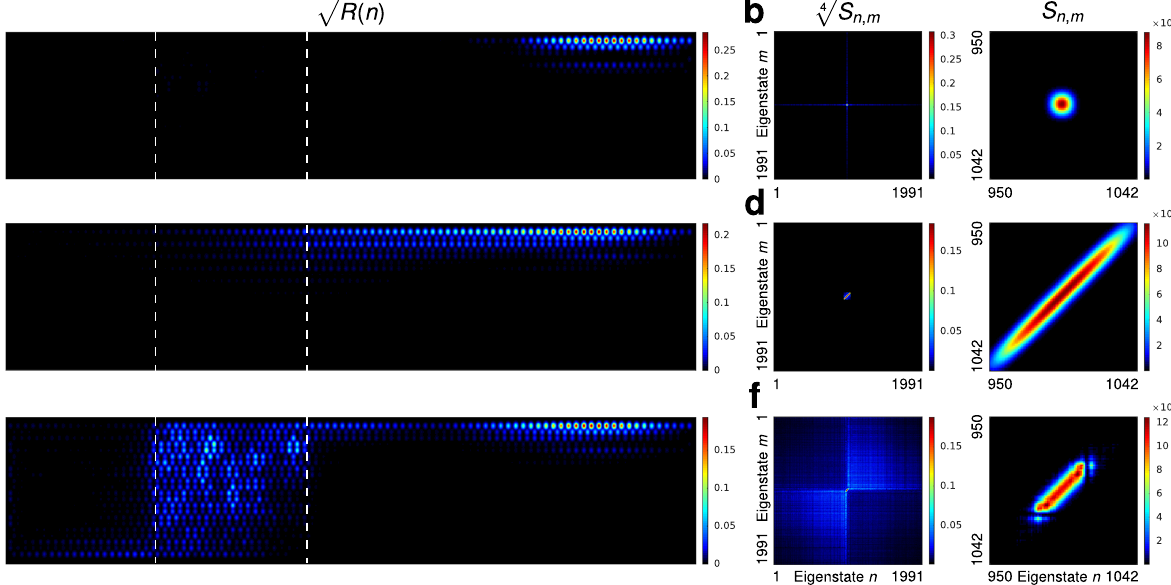
(cid:4) (cid:5) (cid:4) propagating in the clean lattice, while c